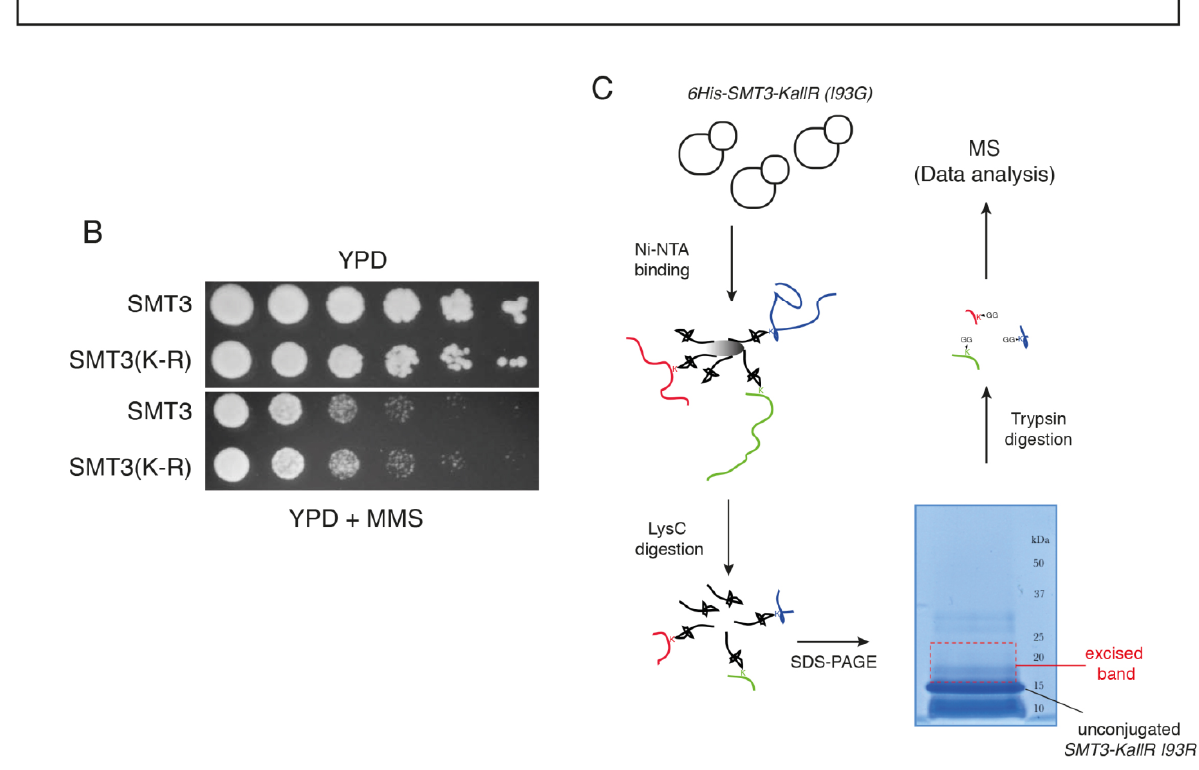
FIGURE 1: Proteomic screen to identify SUMO sites in budding yeast proteins. (A) Sequences of wildtype SUMO ( SMT3 ) and the lysine- deficient His6 tagged mutant ( SMT3-KallR I93R ) used in the method. (B) Wild-type and SMT3-KallR I93R strains plated on full media (YPD) and media containing methyl methanesulphonate (MMS). (C) Diagrammatic representation of the purification strategy employed to enrich for SMT3 -conjugated peptides. Cell lysates from yeast expressing SMT3-KallR I93R were digested with the endoprotease LysC, cleaving after lysines. The digested lysates were run on SDS-PAGE. Unconjugated SMT3-KallR I93R (indicated) and SMT3-KallR I93R conjugated to target protein fragments were identified. Gel area above the unconjugated SMT3-KallR I93R band were excised, digested with trypsin, and ana- lyzed by nano LC-MS/MS. And database searched to identify SUMO acceptor lysines in the yeast